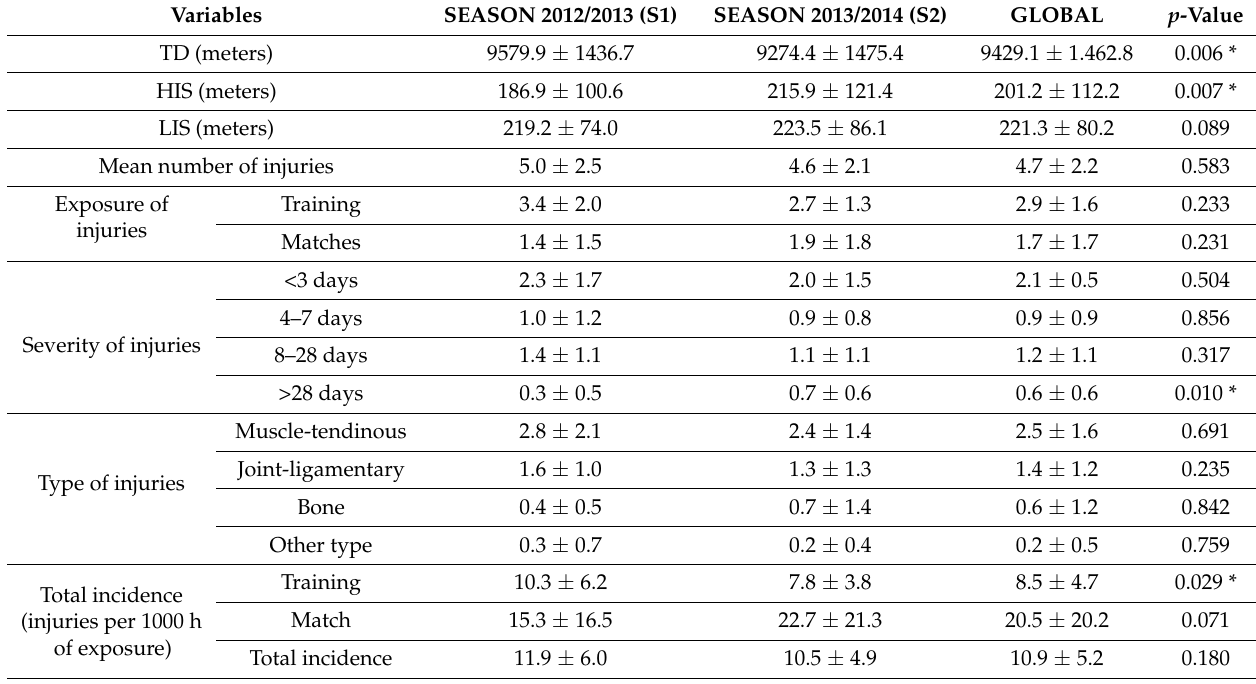
Table 1. Differences in the physical demands variables and injury incidence between two